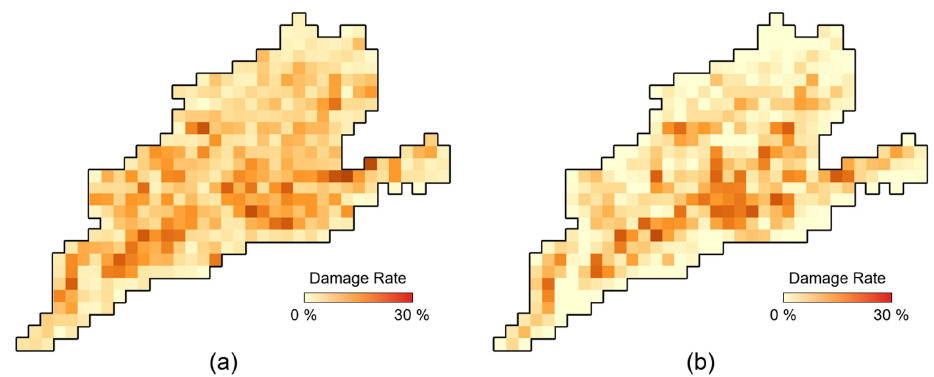
Figure 10. The grid-based damage rate map derived from ( a ) the LTCHD-based change detection result and ( b ) from the OSM-based reference damage map.